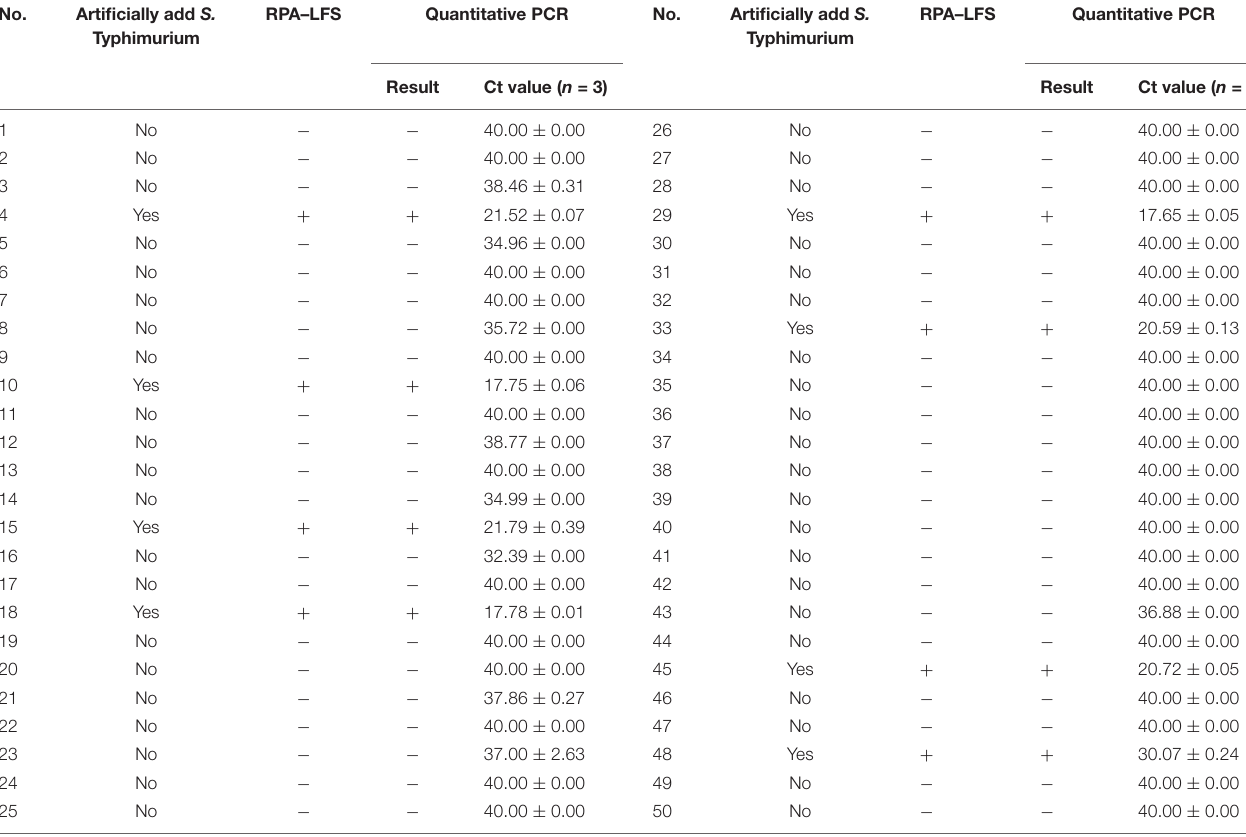
TABLE 6 | Detecting performance of the recombinase polymerase amplification (RPA)–lateral flow strips (LFS) test and quantitative polymerase chain reaction (PCR). No. Artificially add S.